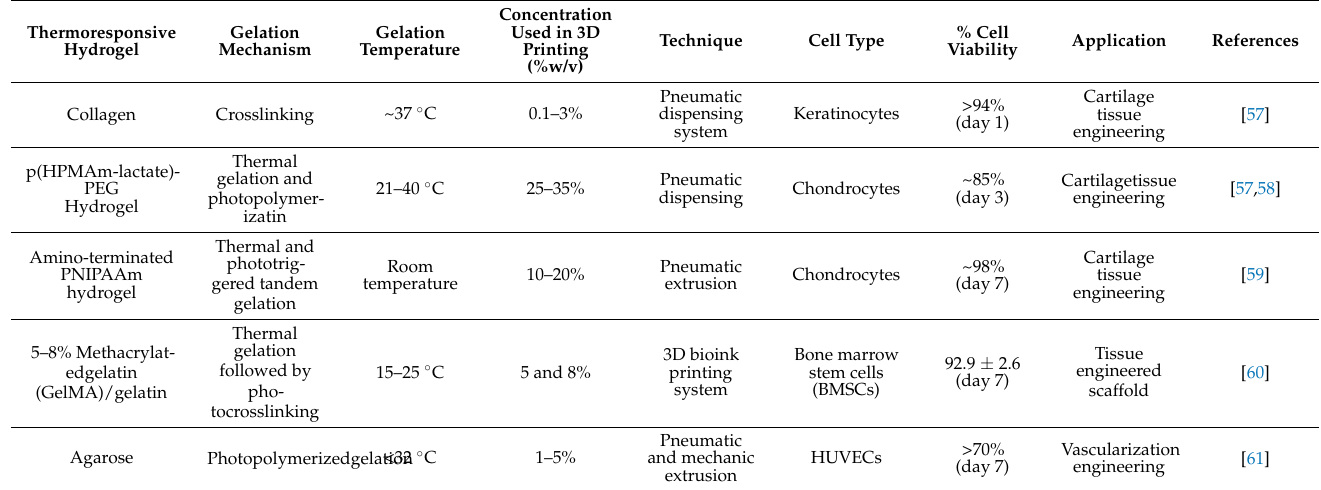
Table 2. Thermoresponsive gels in 3D